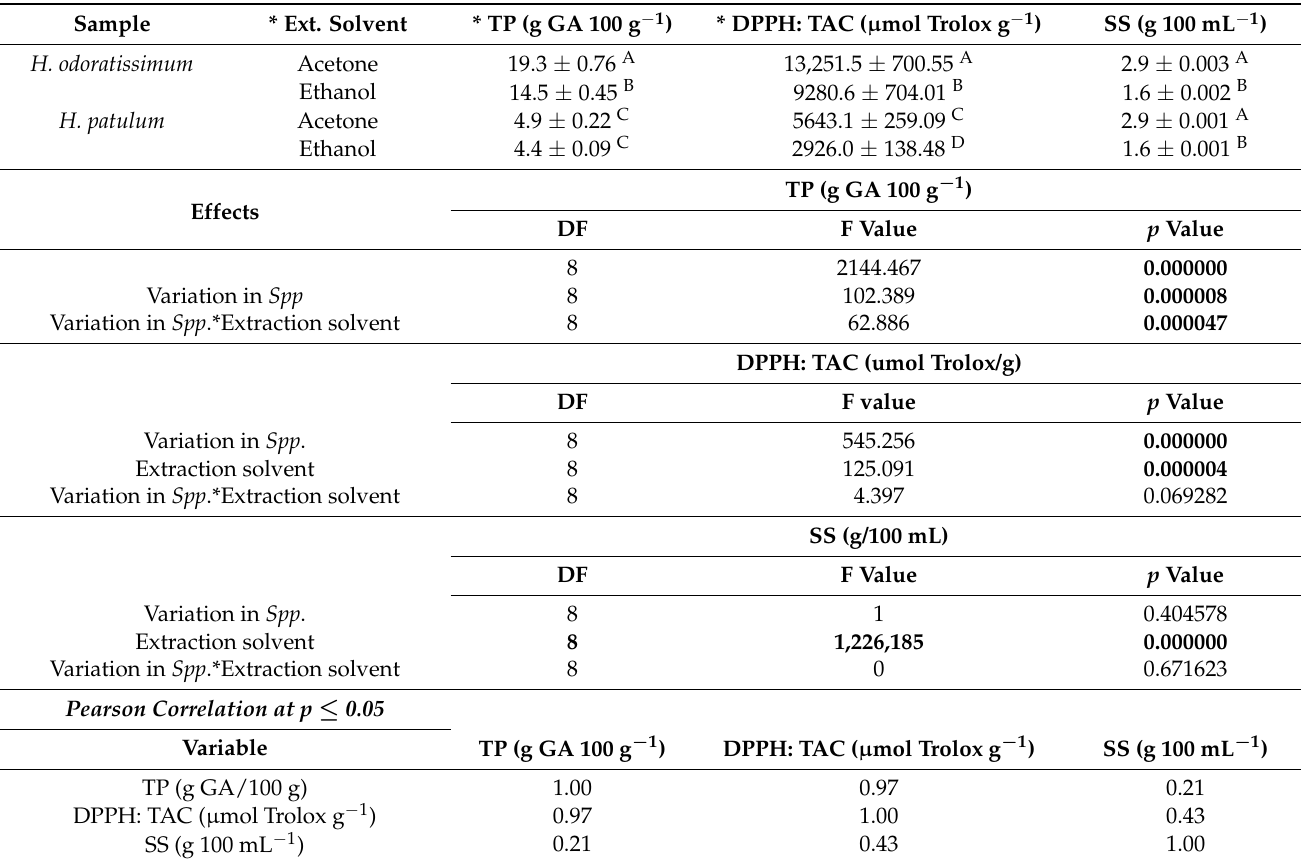
Table 1. Effects of variation in Helichrysum spp. and extraction solvents on the total polyphenol (TP), antioxidant capacity (TAC), and soluble solid (SS) yield on the crude extracts (on dry weight